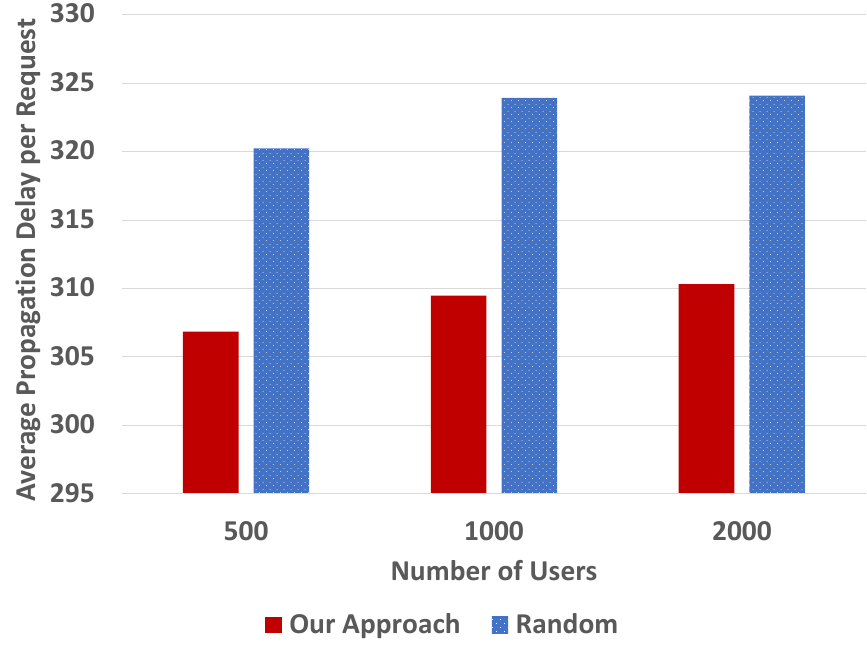
Figure 11. Average propagation delay per request (normalized): 32 regions, 1024 drives per